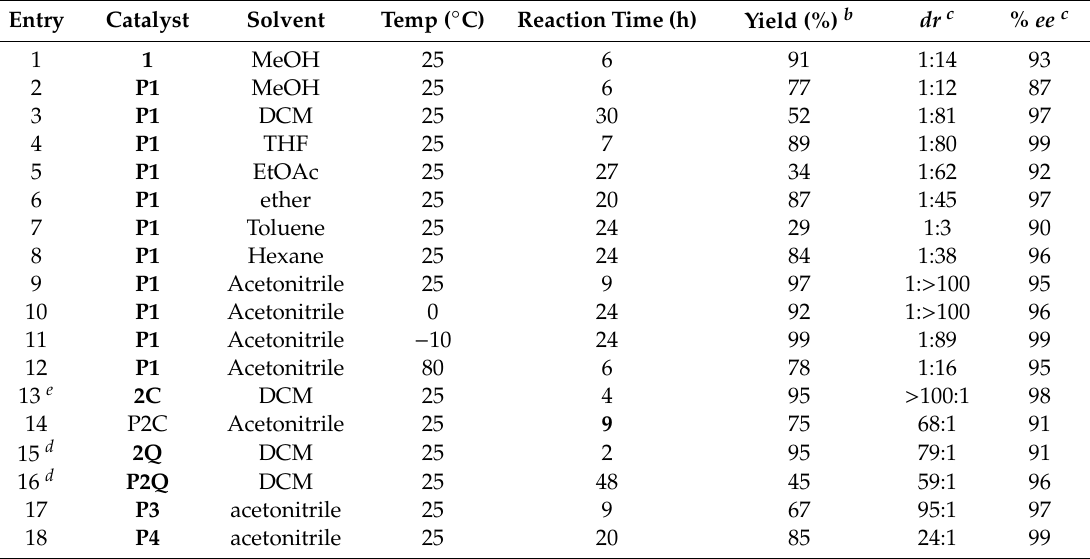
Table 2. Asymmetric Michael addition of 5 and 6 using the ADMET polymeric catalyst a .